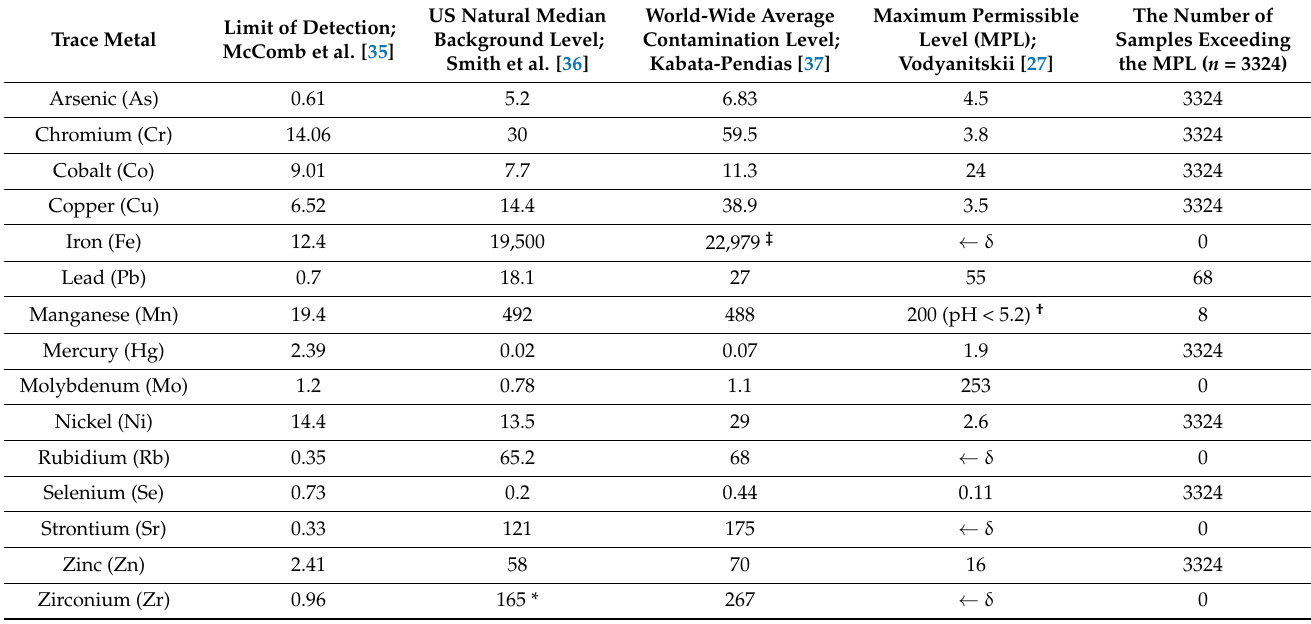
Table 1. Selected relevant Syracuse soil sample attributes for the 15 trace